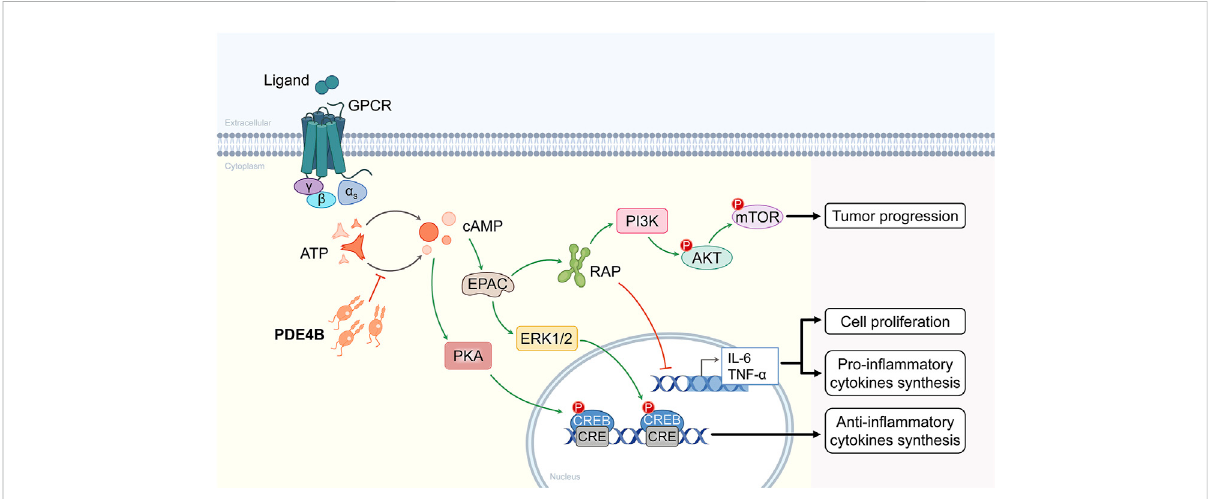
FIGURE 2 Molecular mechanismsofthesignalingpathwaysinvolvedinPDE4B. PDE4Bisinvolved inthePI3K/AKT/mTORsignalingpathwayandtheother is through speci fi c hydrolysis of cAMP followed by activation of the PKA signaling pathway.